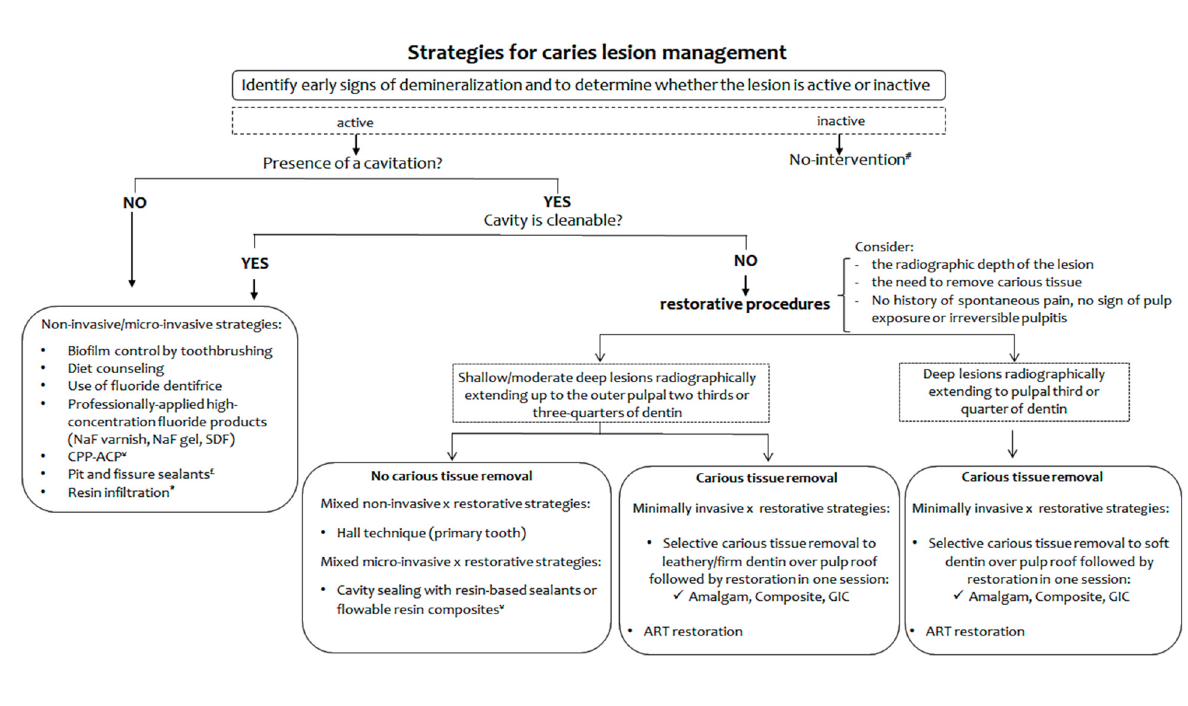
Figure 1. Decision-making flowchart for the management of non-cavitated and cavitated lesions adapted to the LACC context. NaF: sodium fluoride; SDF: silver diamine fluoride solution; CPP-ACP: casein phosphopeptide-amorphous calcium phosphate; ART restoration: Atraumatic restorative treatment; ¥ More evidence from clinical studies are necessary; £ For non-cavitated lesions or cavitated lesions restricted to the enamel. Dentinal involvement of occlusal lesions must be assessed using bitewing radiographs; * For non-cavitated lesions only; # except for inactive cavitated lesions requiring protection of the pulp–dentin complex and recovery of the tooth´s function, form, and